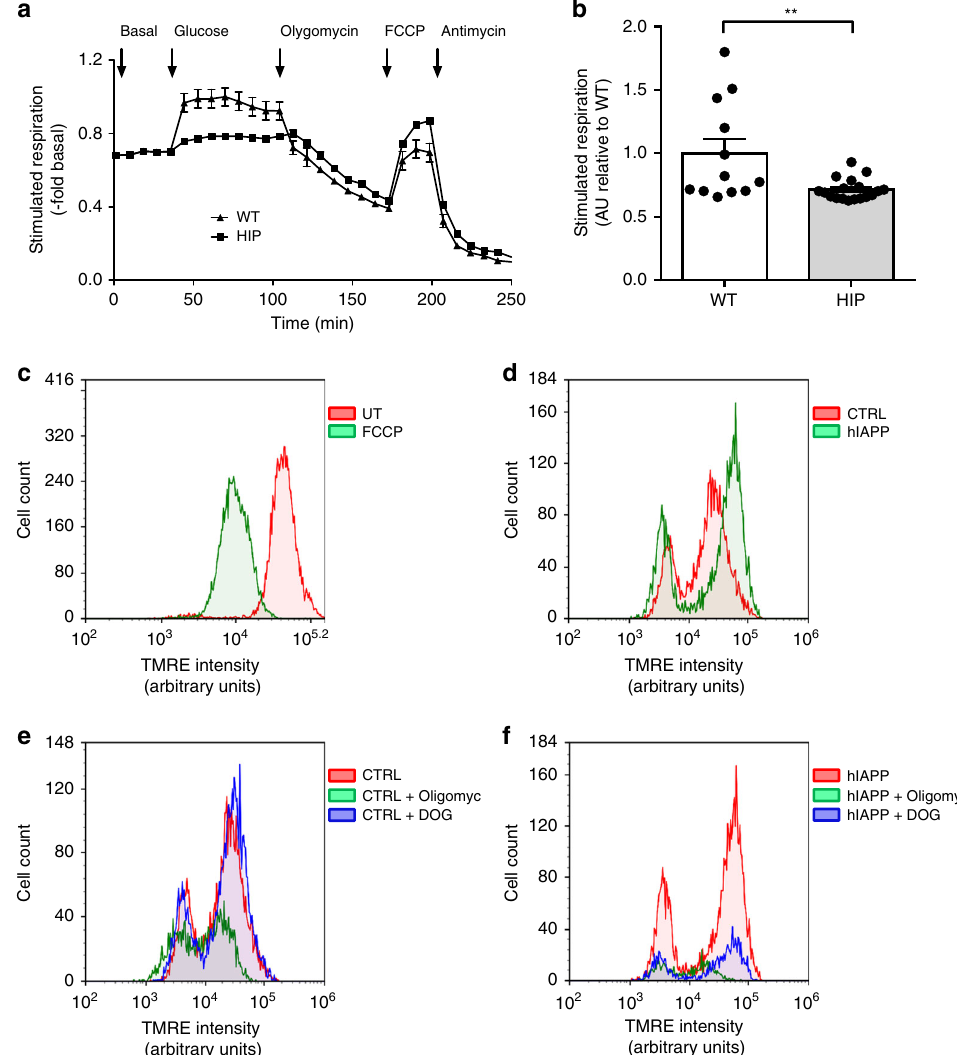
Fig. 5 Mitochondrial respiration is decreased by hIAPP. a Oxygen consumption rate (OCR) measurements were obtained over time (min) using an extracellular fl ux analyzer (Seahorse Bioscience). Bioenergetic parameters were obtained by adding glucose (20 mM) to derive OCR under